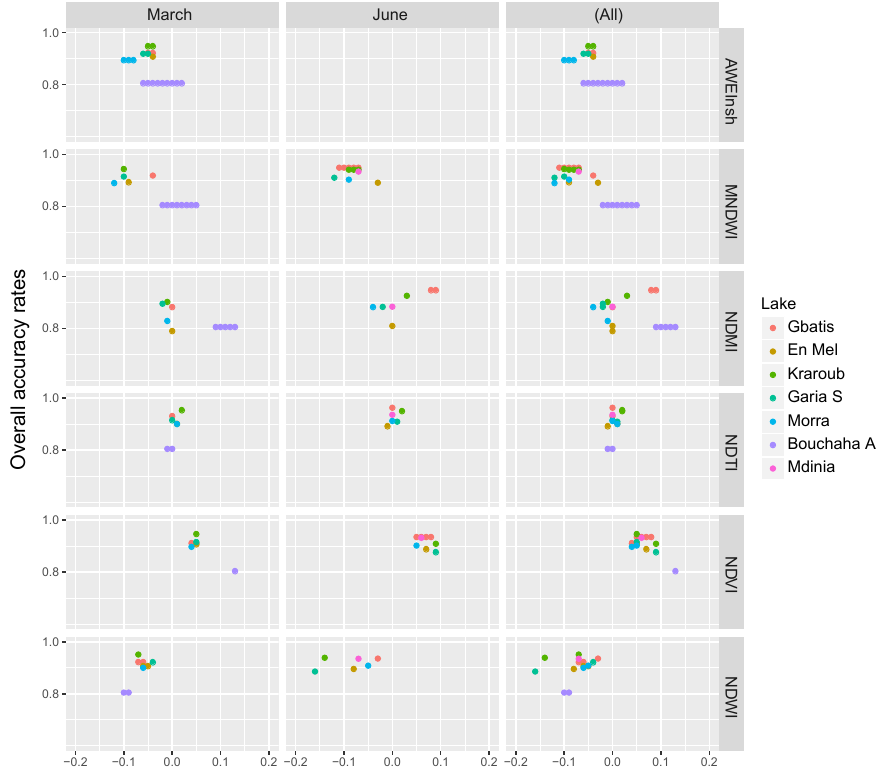
Figure 5. Optimal threshold (based on overall accuracy) for each lake and index on March and June calibration images.